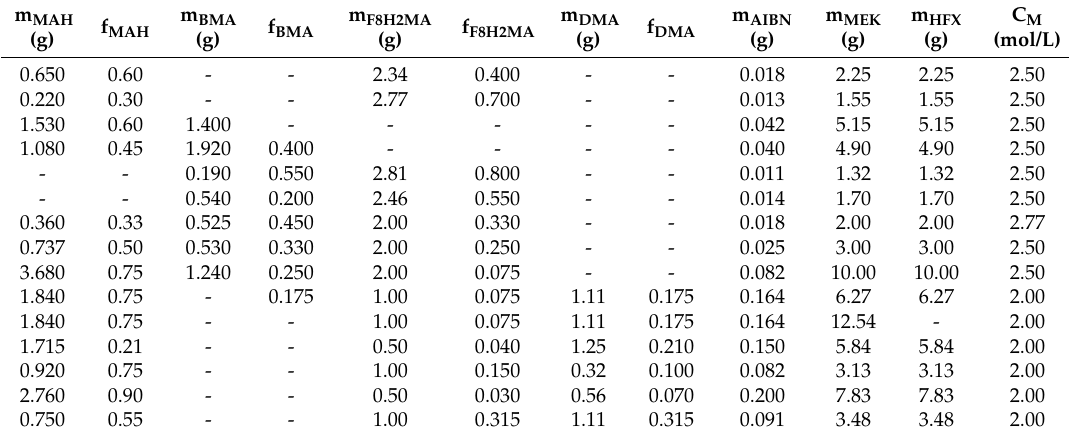
Table 1. Composition of the reaction mixtures for low conversion copolymerization of monomer systems: MAH/F8H2MA, MAH/BMA, BMA/F8H2MA, BMA/F8H2MA/MAH,